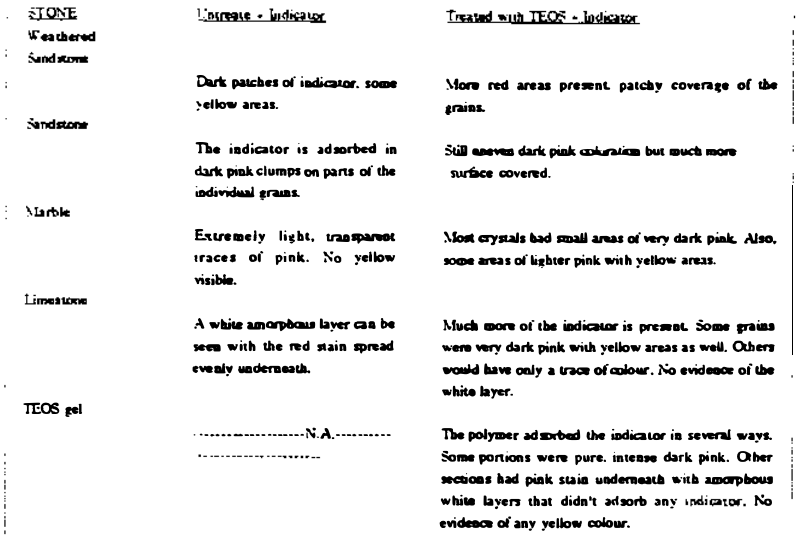
Table 4 Colour change of treated and control